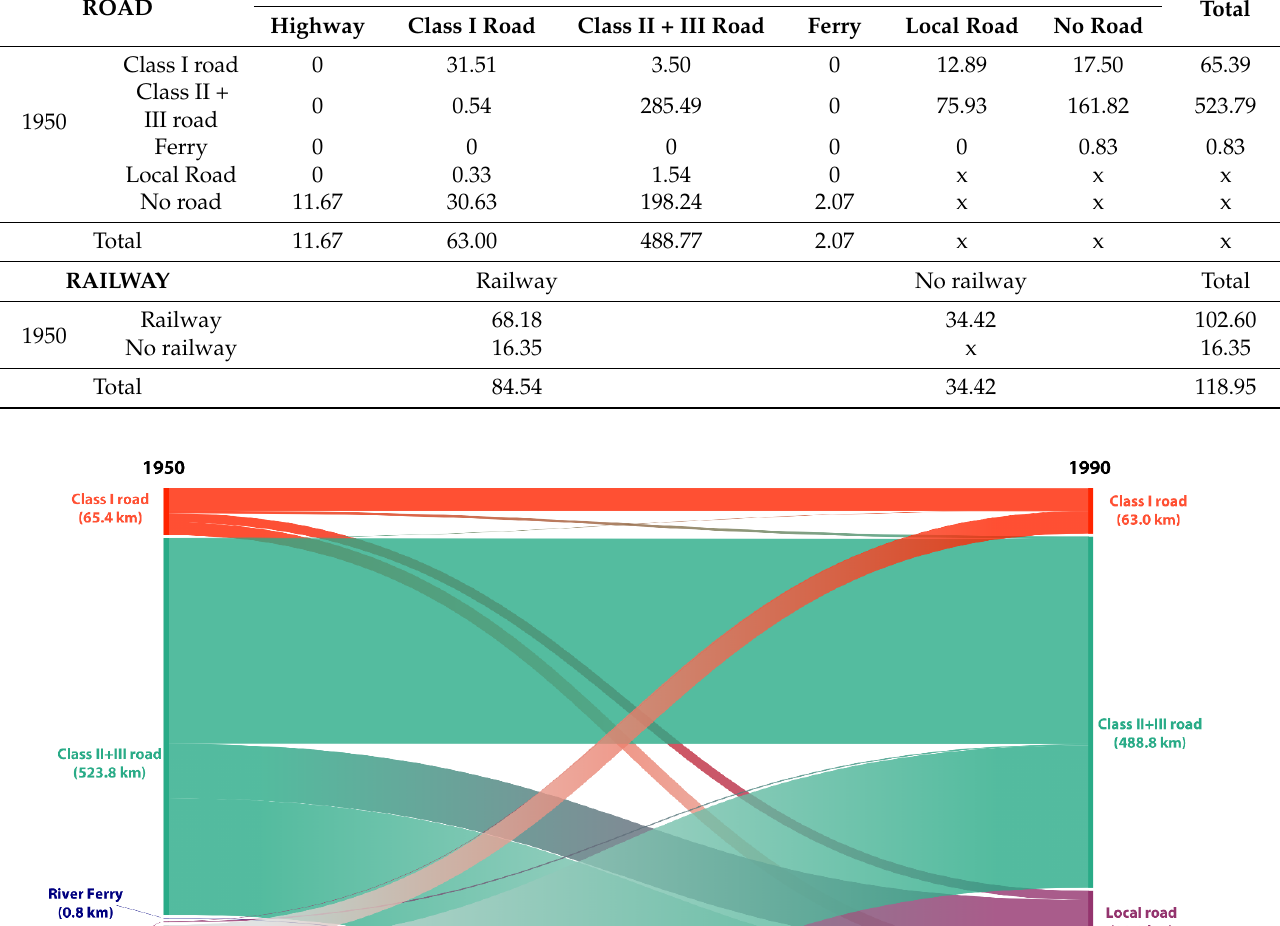
Table 7. The transport network changes: the lakes ( n = 29) constructed in 1950/1990 [km].